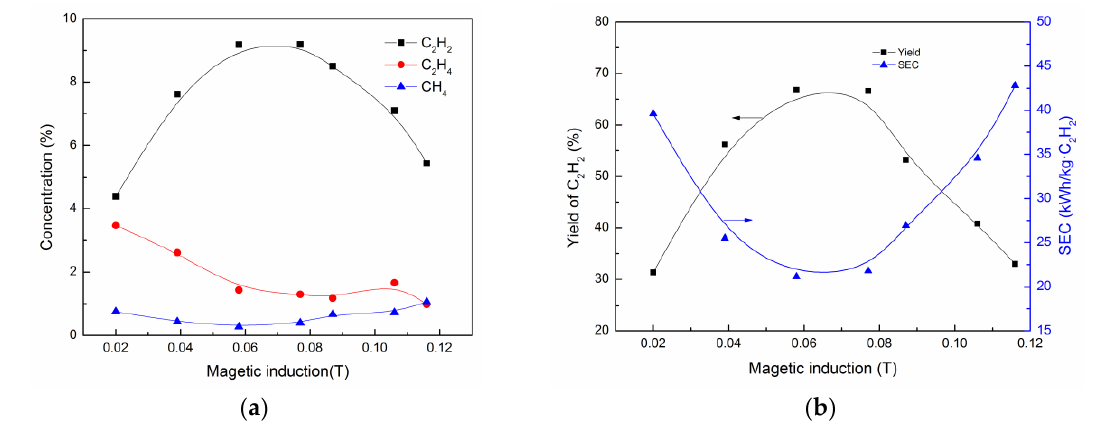
Figure 8. The effect of magnetic induction on the performance of toluene pyrolysis. ( a ) concentration, ( b ) yield and SEC; Reaction conditions: toluene, Q H B = 0.02–0.10 T, I = 80 A, P = 16.0